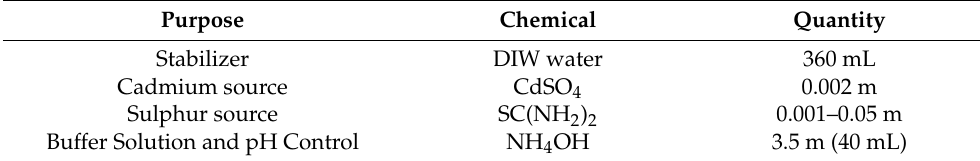
Table 1. Chemical reagents used in CBD process. Purpose Chemical Quantity Stabilizer DIW water 360 mL Cadmium source CdSO 4 0.002 m Sulphur source SC(NH 2 )